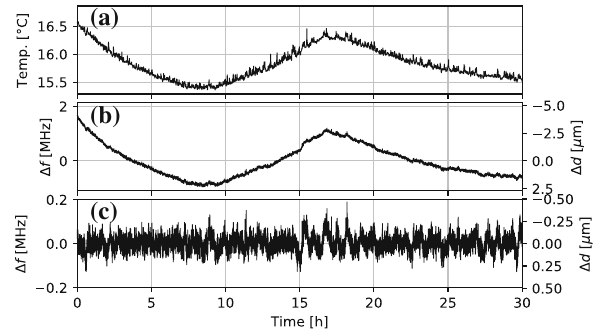
Fig. 5 Effectofmechanicaldeformationoftheproofofprinciplesetup overalong-termmeasurementwithasinglediskandmirror. a Measured temperature as a function of time. b Measured frequency of the 7th har- monic of the group delay peak as a function of time. The secondary axis shows the corresponding positioning error of the dielectric disk. More details are given in the text. c Measured group delay peak frequency and corresponding position deviation after subtracting variations on the time scale of an